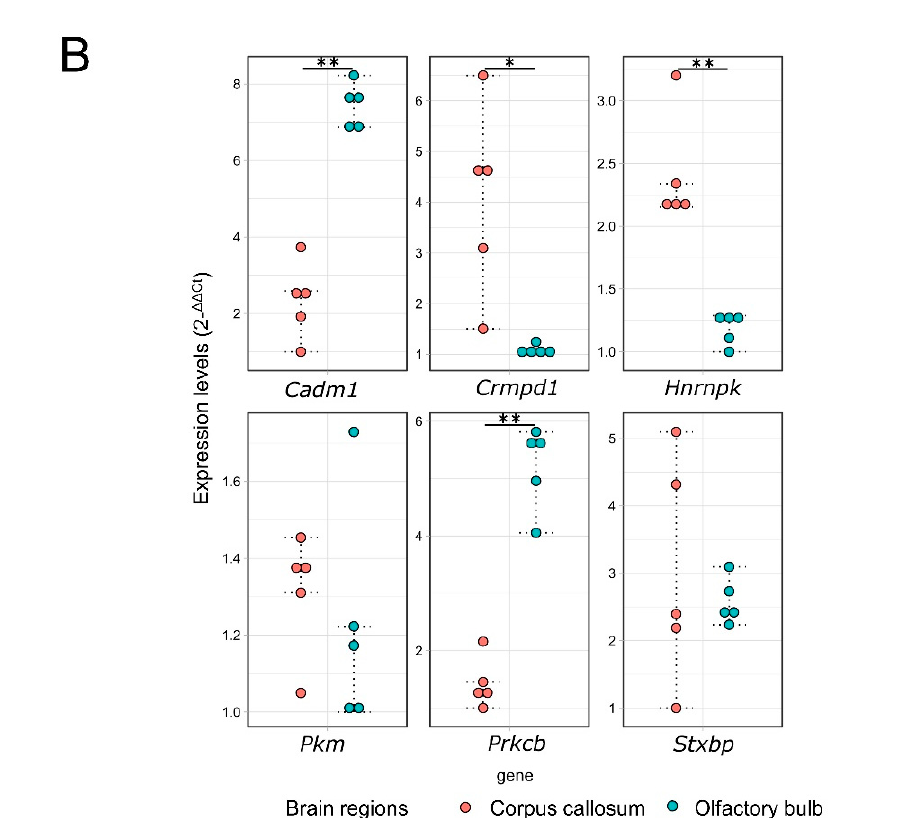
Figure 5. RNA-Seq expression levels for the orthologous alternatively spliced proteoforms selected for mRNA experimental validation. ( A ) Comparative analysis of transcript expression levels in transcripts per million (TPM) across the corpus callosum and olfactory bulb in mice and humans. The Y-axis shows the expression of transcripts in TPM, and the X-axis shows the different transcripts. ( B ) Transcript expression levels (2 − ∆∆ Ct ) of the AS variants of the genes Cadm1, Crmpd1, Hnrnpk, Pkm, Prkcb, and Stxbp in the mouse CC and OB. Two-sample t-test; p -value ≤ 0.05 (*) and p -value ≤ 0.01 (**).